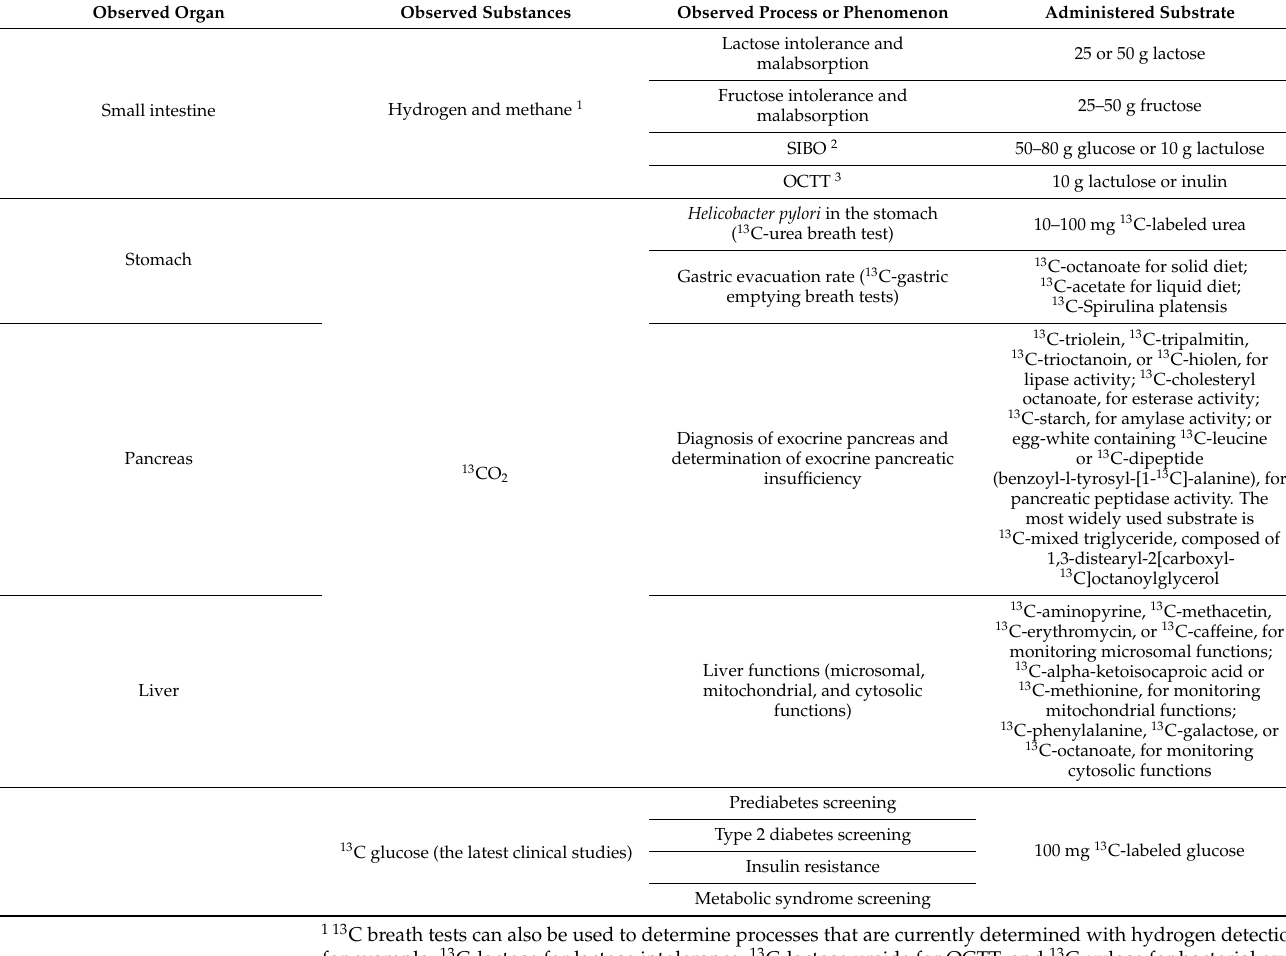
Table 1. Current usage of breath tests